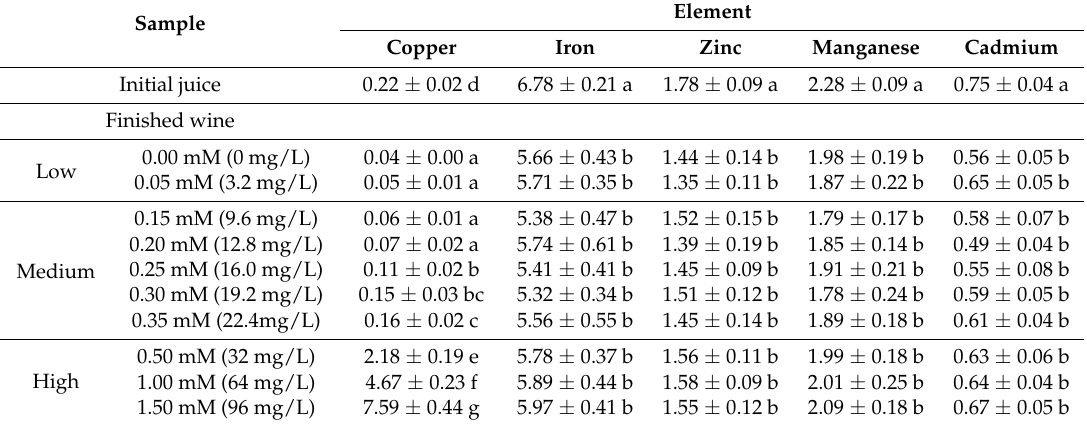
Table 2. Contents of copper, iron, zinc, manganese and cadmium in initial juice and in finished wine. Sample